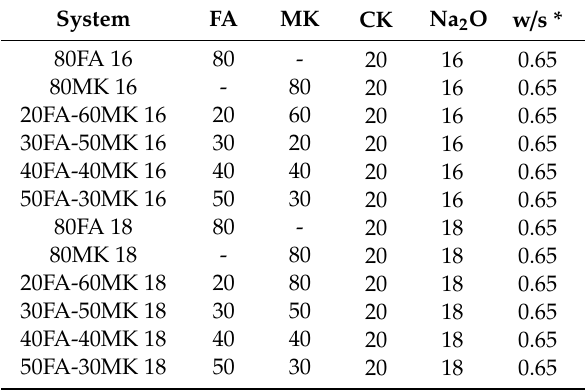
Table 3. Percentage of precursor powders in